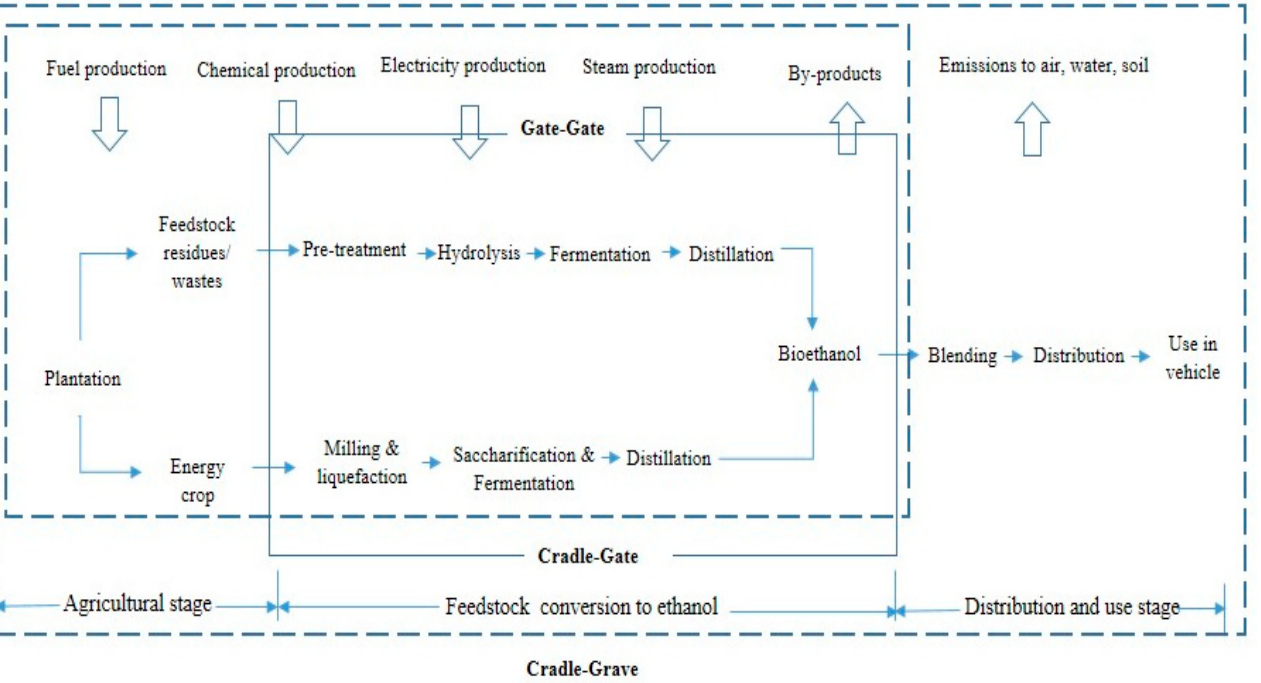
Figure 3. An overview of system boundaries and technological process of 1G and 2G bioethanol considered by reviewed papers.